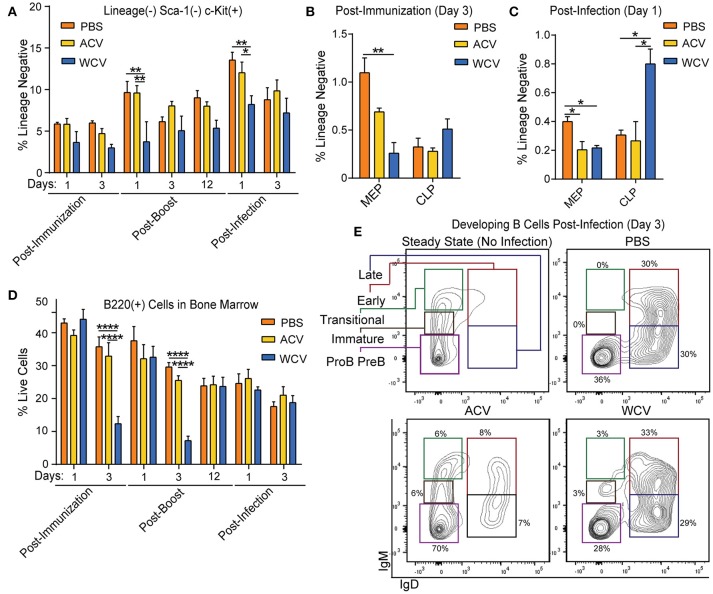
WCV immunization prepares HSPCs for rapid maturation of developing B cells upon subsequent infection. (A) Proportions of lineage−Sca-1+ckit+ (LK) cells were evaluated in the bone marrow of CD-1 mice (n = 4/group for each time point) immunized with phosphate buffered saline (PBS), Bp acellular vaccine (ACV), or Bp whole cell vaccine (WCV) and infected with 107 CFU Bp using flow cytometric analysis. (B) Proportions of megakaryocyte erythroid progenitors (MEPs) and common lymphoid progenitors (CLPs) were evaluated in mouse bone marrow (n = 4/group for each time point) post-immunization and (C) post-infection by flow cytometric analysis. (D) Proportions B220+ cells were evaluated in mouse bone marrow (n = 4/group for each time point) using flow cytometric analysis. (E) Representative dot plots from further gating on cells from part D are shown. *p < 0.05; **p < 0.01; ****p < 0.0001; 2-way ANOVAs with Tukey's multiple comparisons. Error bars are mean ± SEM values.